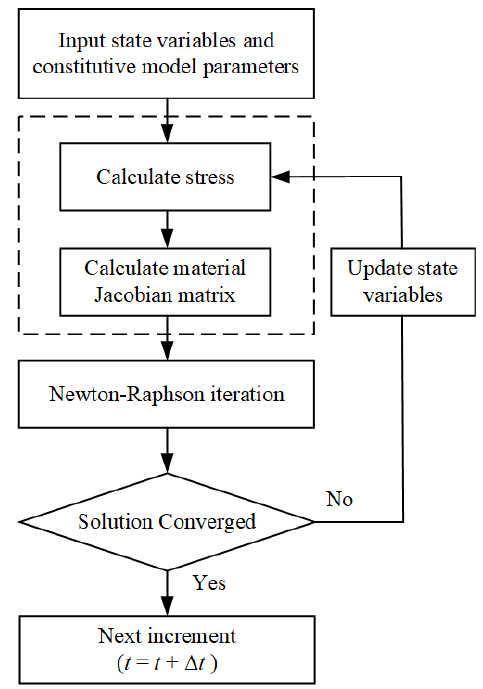
Figure 7. Flow chart of UHYPER implementation in ABAQUS.